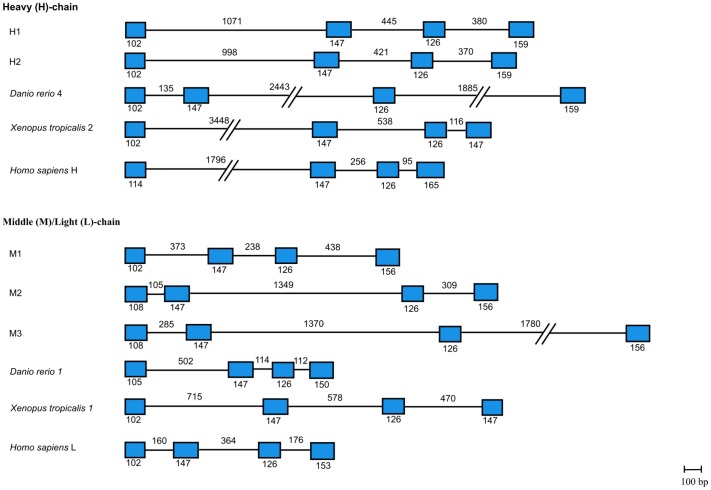
Comparison of the gene organisation of H1, H2, M1, M2 and M3 from S. salar with ferritin sequences from other vertebrates.Exons and introns are represented respectively by the blue boxes and black lines. Numbers below and above the boxes respectively indicate exon sizes and intron sizes. The length of exons and introns is drawn to scale except for intron sizes exceeding 1500//.